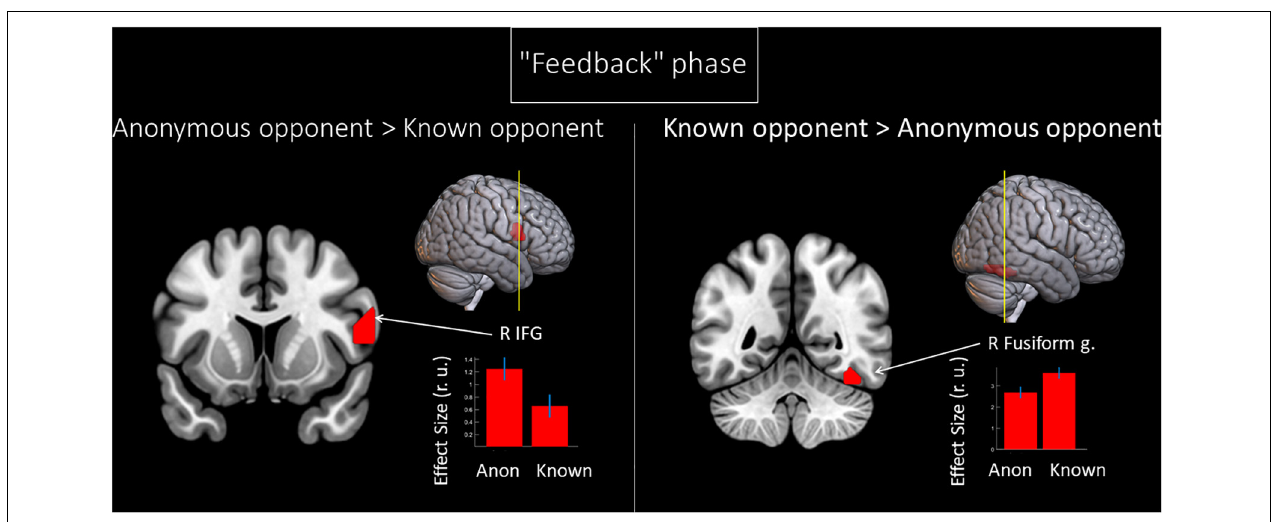
FIGURE 3 | Results of the group-level BOLD signal analysis. Clusters of increased BOLD signals associated with the observation of provocation for the F-contrast “Anonymous opponent vs. Known opponent” (uncorrected p < 0.001 at the voxel level, FWE-corrected at the cluster level p < 0.05, and k = 15). Plots show effect sizes with 95% confidence intervals. L/R, left/right hemisphere; g., gyrus; IFG, inferior frontal gyrus; Anon, anonymous opponent; Known, introduced opponent.